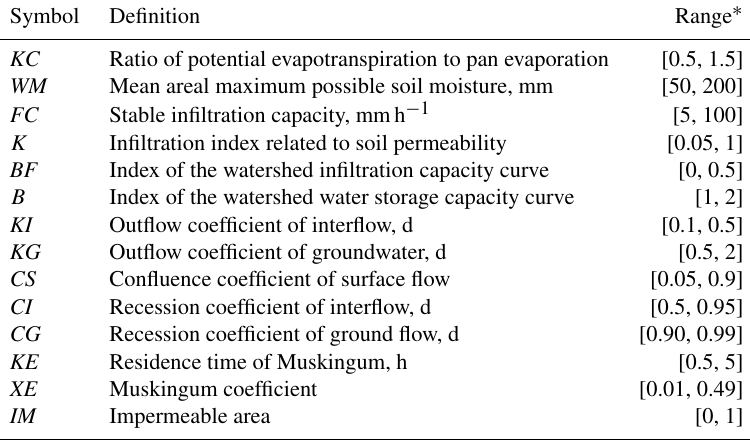
Table 2. Parameter values of the